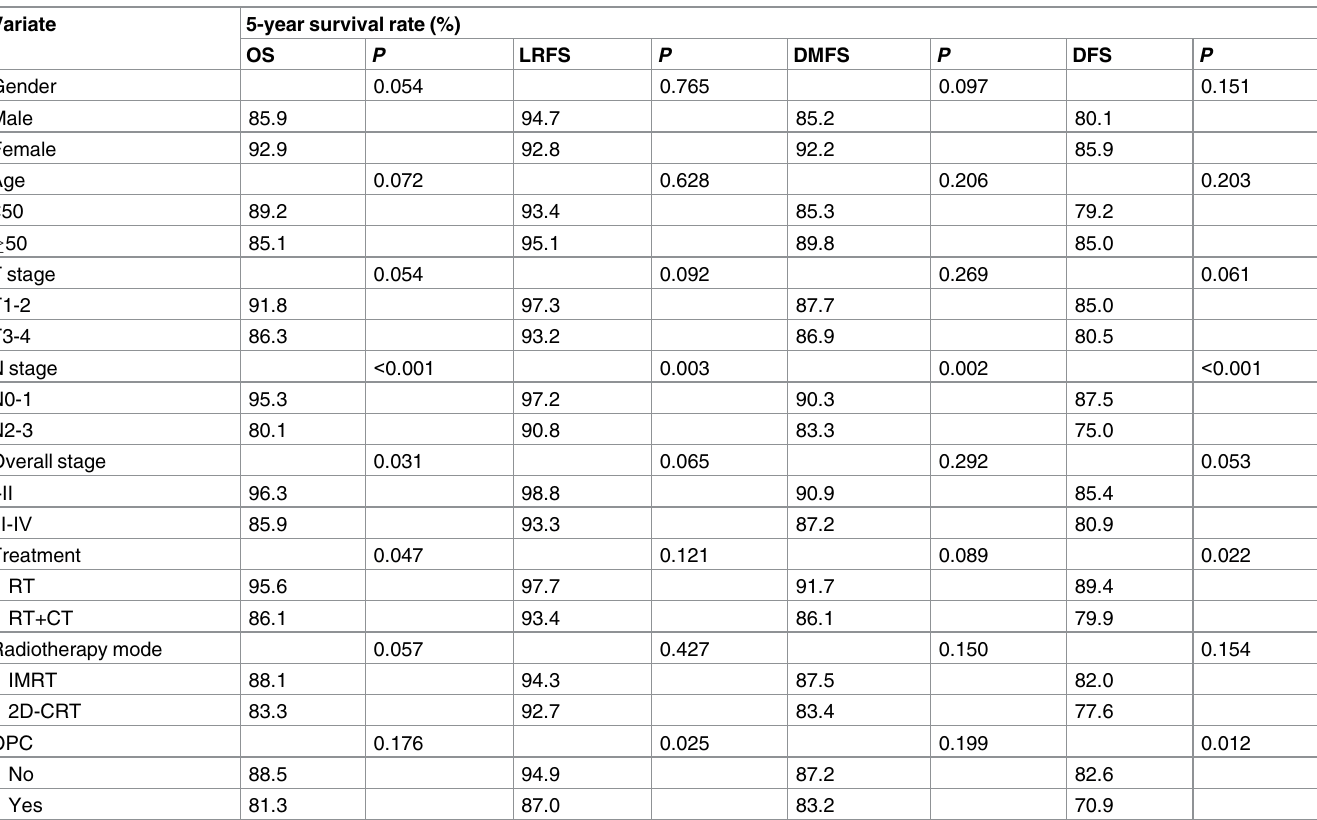
Table 6. Univariate analysis of prognostic factors for NPC patients.